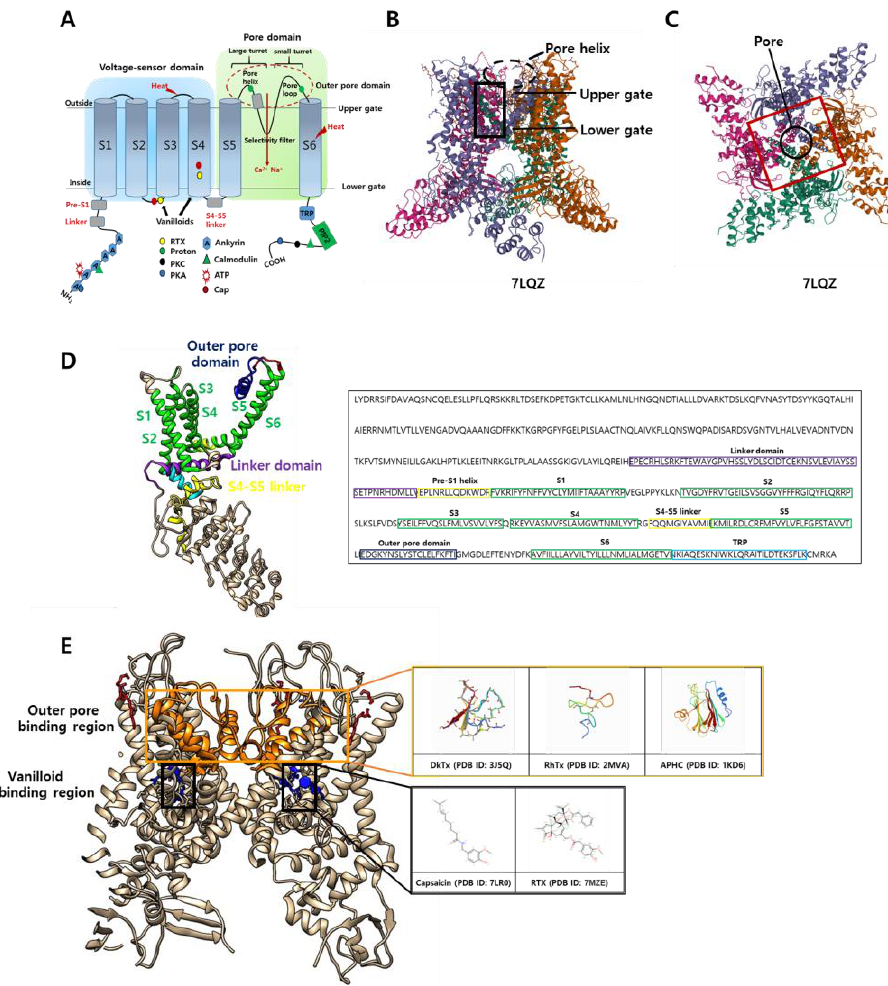
Figure 1. The structure and binding sites of the transient receptor potential vanilloid 1 (TRPV1) channel. ( A ) TRPV1 is a homotetrameric transmembrane protein containing a voltage-sensory domain, pore domain, S4–5 helix linker, and TRP box. The N-terminal end comprises ankyrin repeats and a calmodulin interaction site, while the C-terminal end contains a PIP2 interaction site. Amino acid residues at both ends can be phosphorylated by PKC and PKA. Vanilloid agonist sites are located in the S2–4 transmembrane domain. Both heat- and protein-initiated stimuli are mediated by specific residues located in the extracellular membrane domain (or loops). The selectivity filter is formed by the loop connecting the pore helix and S6 helix. The large and small turret subunits are connected to the S5 and S6 domains. The outer pore domain is indicated by a red dashed circle. ( B ) Side view of the TRPV1 structure: the tetrameric structure of the pore helix and the upper and lower gates, which regulate channel activation. The vanilloid pocket region is highlighted by the black box, and the pore helix is indicated by a black dashed circle (PBD ID: 7LQZ). ( C ) Top view of the TRPV1 structure: the outer pore region is highlighted by a red box, and the pore region is indicated by a black circle (PBD ID: 7LQZ). The symbols beneath each 3D structure are the access numbers in the Protein Data Bank (PDB). ( D ) Side view of a single TRPV1 subunit color coded as described in B (PDB ID: 7L2S). Sequence alignment of rat TRPV1 construct (NW_024405602); linker domain, pre-S1 helix (linker), S1–6, outer pore domain, and TRP are highlighted in purple, yellow, green, dark blue, and light blue, respectively. ( E ) Side view of the TRPV1 tetrameric structure (PDB ID: 7L2S) showing the outer pore binding venom peptides (DkTx, RhTx, and APHC) and their sites (orange box). Similarly, vanilloid binding agonist (capsaicin and RTX) and its site (black box) are